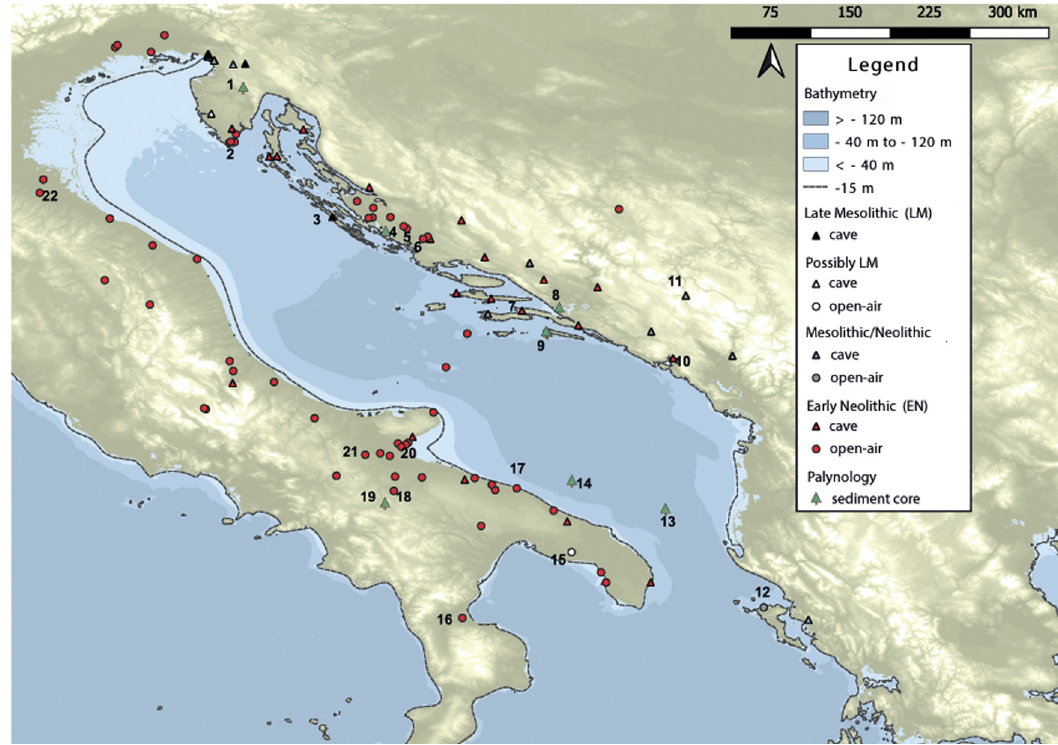
Figure 3: Location of the main eastern Adriatic Mesolithic and Neolithic sites in relation to post - glacial sea - level rise. Sites mentionned in text: ( 1 ) Prapo č e, ( 2 ) Kargadur, ( 3 ) Vlakno ( Dugi Island ) , ( 4 ) Vransko lac, ( 5 ) Ra š inovac, ( 6 ) Pokrovnik, ( 7 ) Ž ukovica ( Kor č ula ) , ( 8 ) Neretva, ( 9 ) Veliko and Malo lake ( Mljet island ) , ( 10 ) Crvena Stijena, ( 11 ) Odmut, ( 12 ) Sidari ( Corfu ) , Nevigata, ( 21 ) Ripa Tetta, ( 22 ) Fornace Cappuccini ( Faenza )